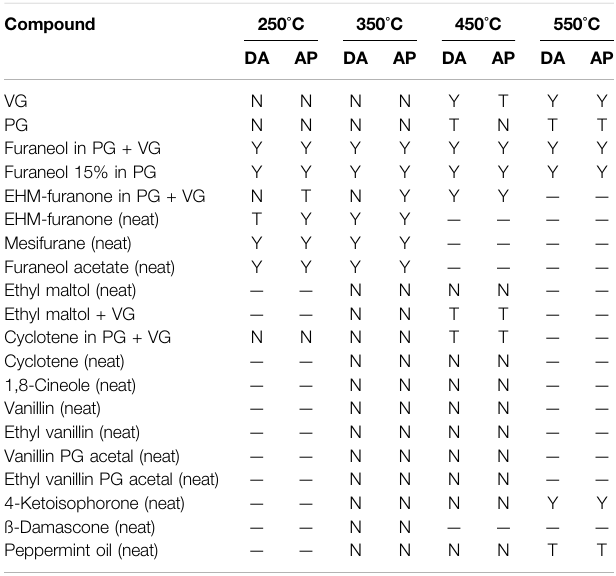
TABLE 6 | Presence or absence of acetyl propionyl or diacetyl in pyrolysis screening experiments on fl avor compounds.